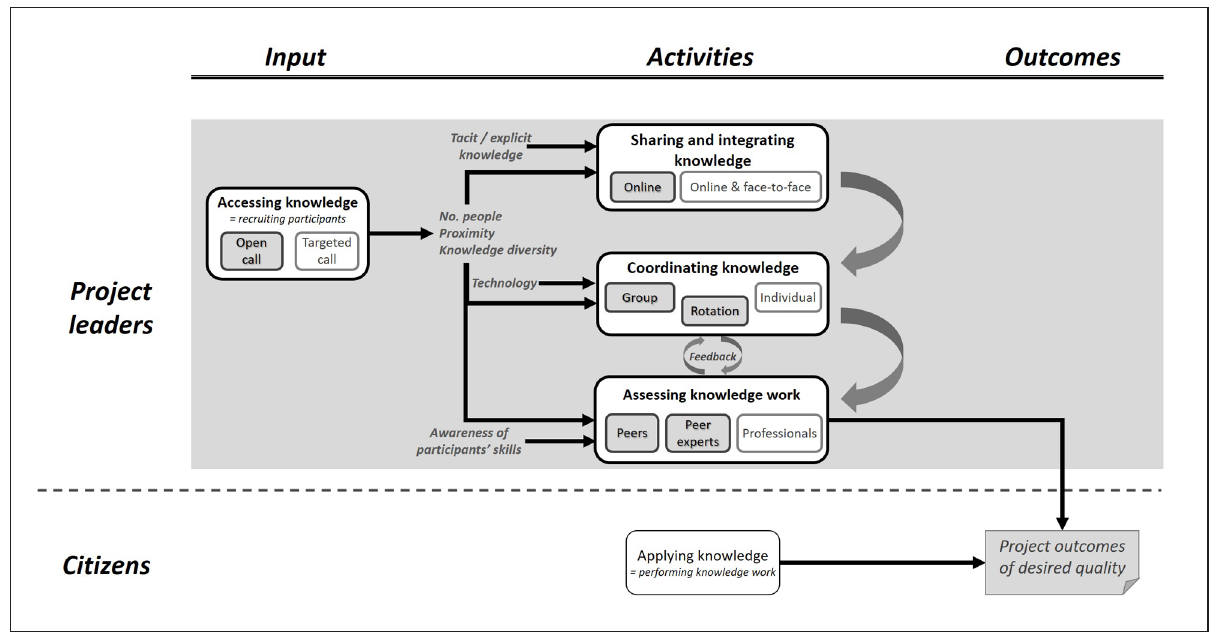
Figure 1: Possible configurations of knowledge-management activities in citizen